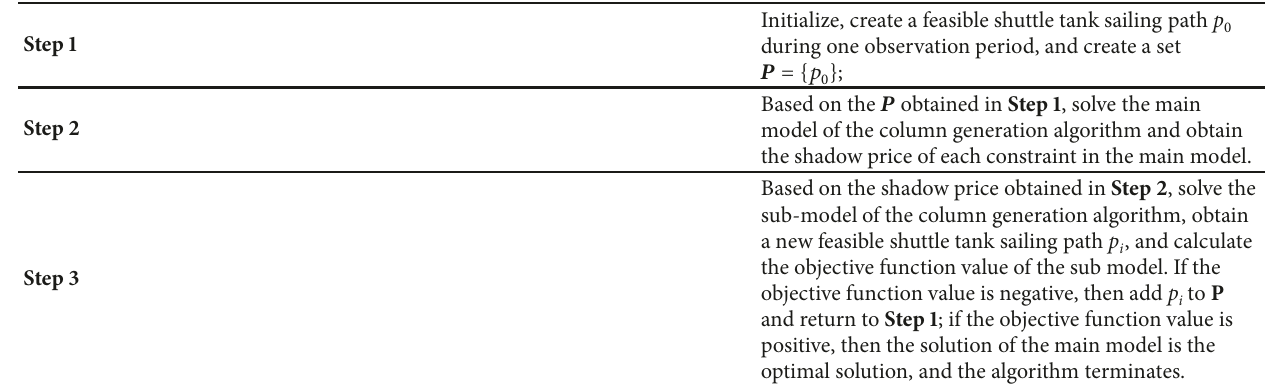
Table 1: Basic process of